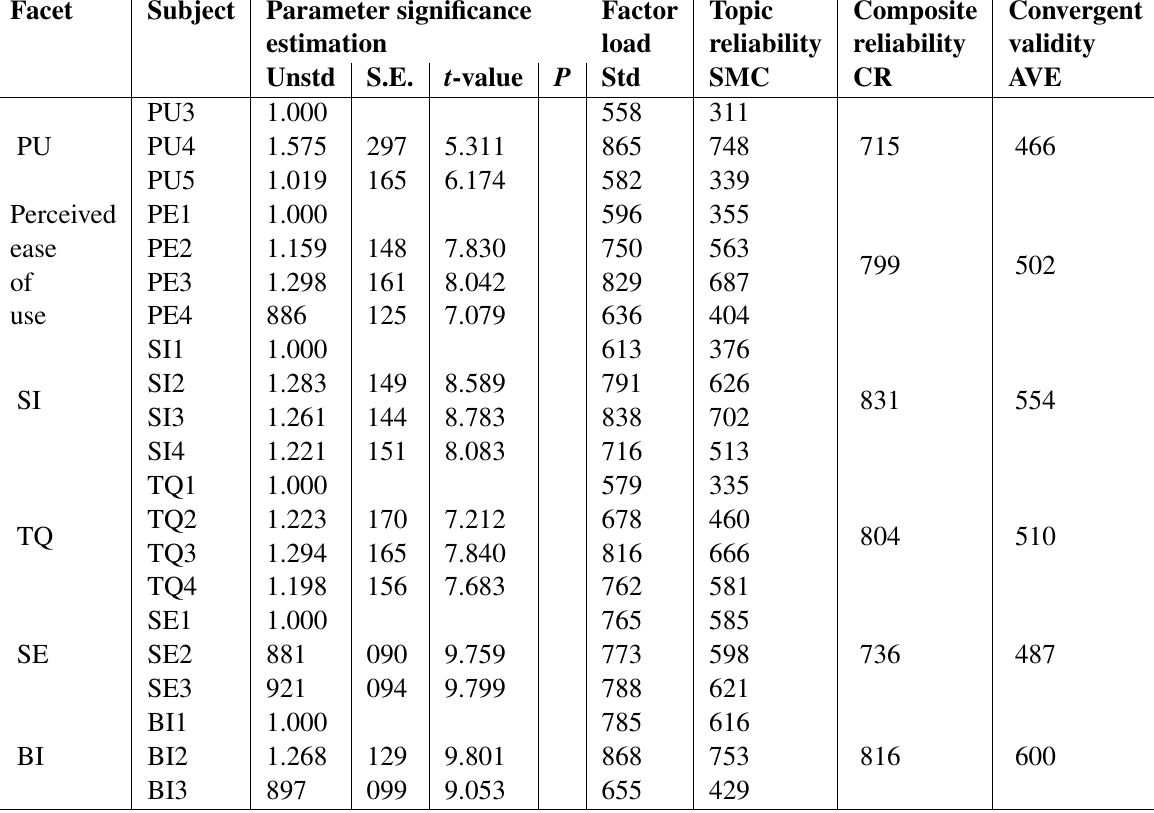
Table 12 Validity analysis among the variables of the structural equation